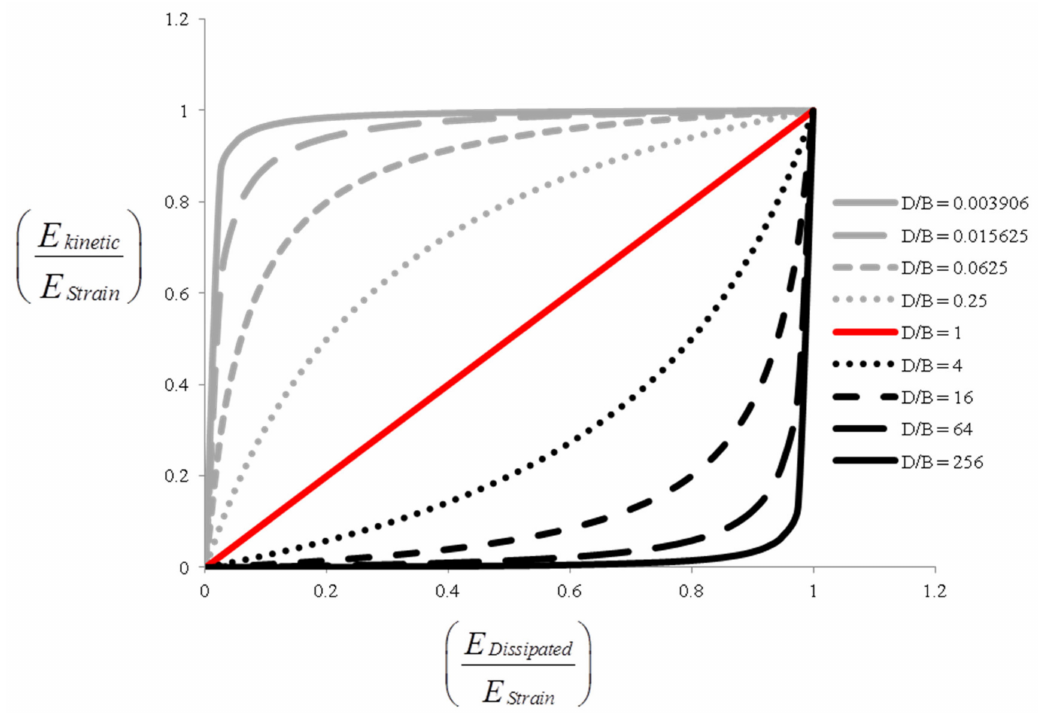
Figure 3. The interaction between the di ff erent types of energy due to the e ff ect of the damage in a coal mass and strata layers ( D / B = 2 n